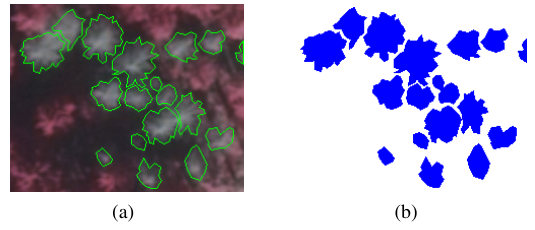
Figure 5. Reference data created using manual delineation in im- age. (a) Contours of marked polygons. (b) Polygon masks cre- ated from